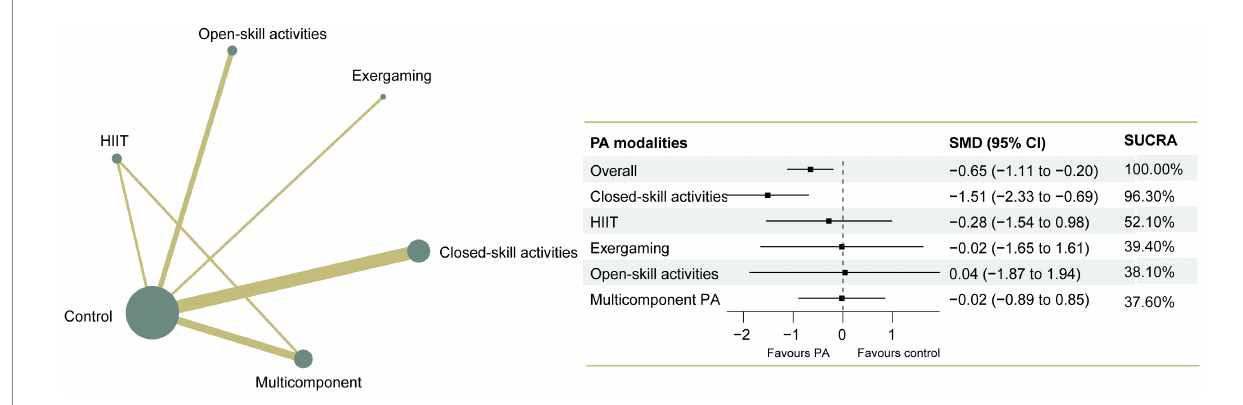
FIGURE 5 Network plot of comparisons and the efficacy of varied treatments compared with the control group for inattention. Each node represents an intervention and its size depends on the number of participants. The connecting lines between 2 nodes represents 1 or more trials in which the 2 interventions have been compared directly. The thickness of the lines connecting 2 nodes is weighted according to the number of trials that directly compared the interventions it connected. PA, physical activity; SMD, standardized mean difference; SUCRA, the surface under the cumulative ranking curve.